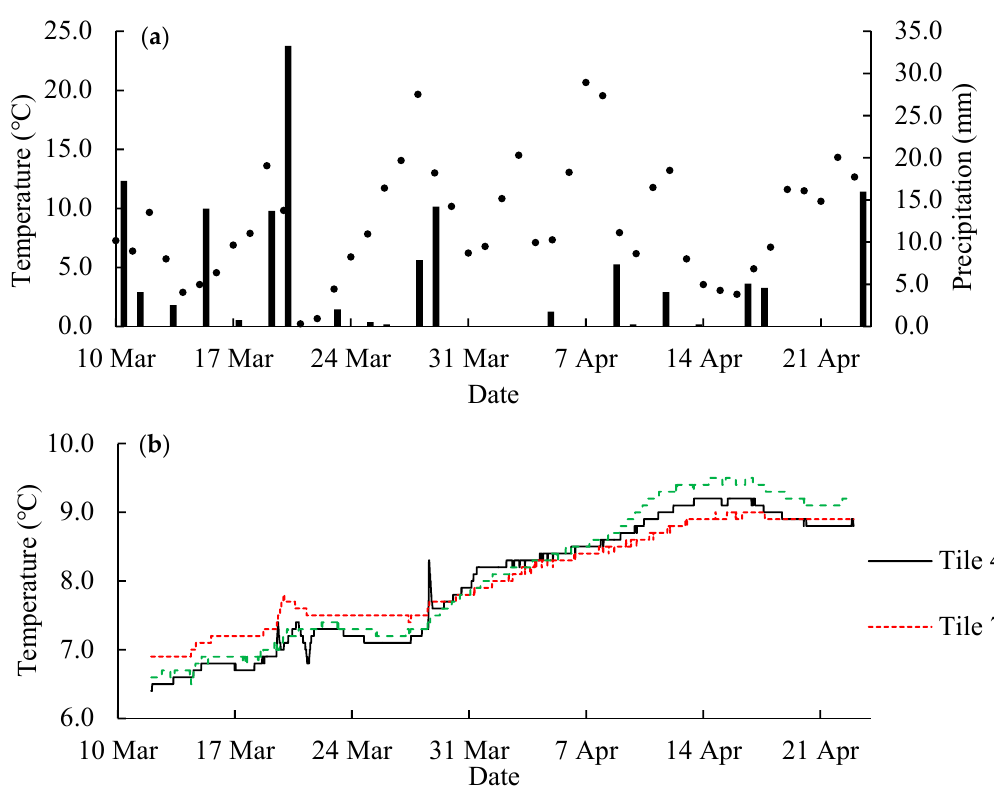
Figure 6. Weather conditions in Spring 2020 at the study site in East-Central Illinois, USA. ( a ) Daily air temperature shown in dots and daily precipitation shown in columns; ( b ) tile water temperature.